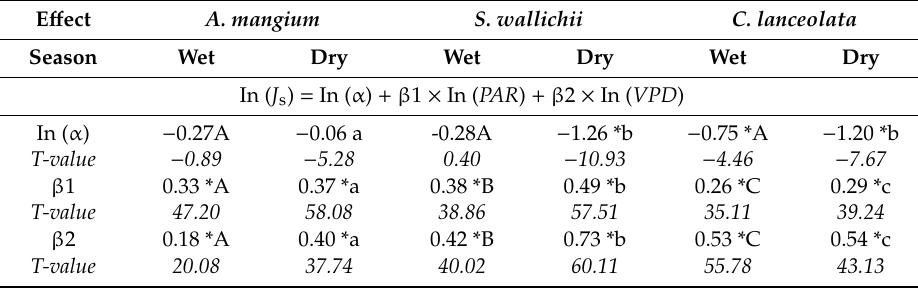
Table 5. Model relating hourly J s to environmental factors in di ff erent seasons and species. E ff ect